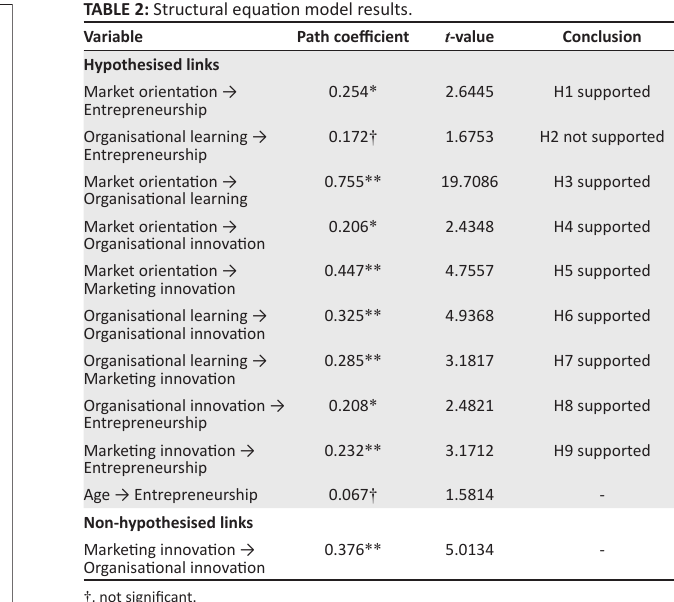
FIGURE 2: Partial least squares structural equation modelling framework of innovation for small-size project-based service